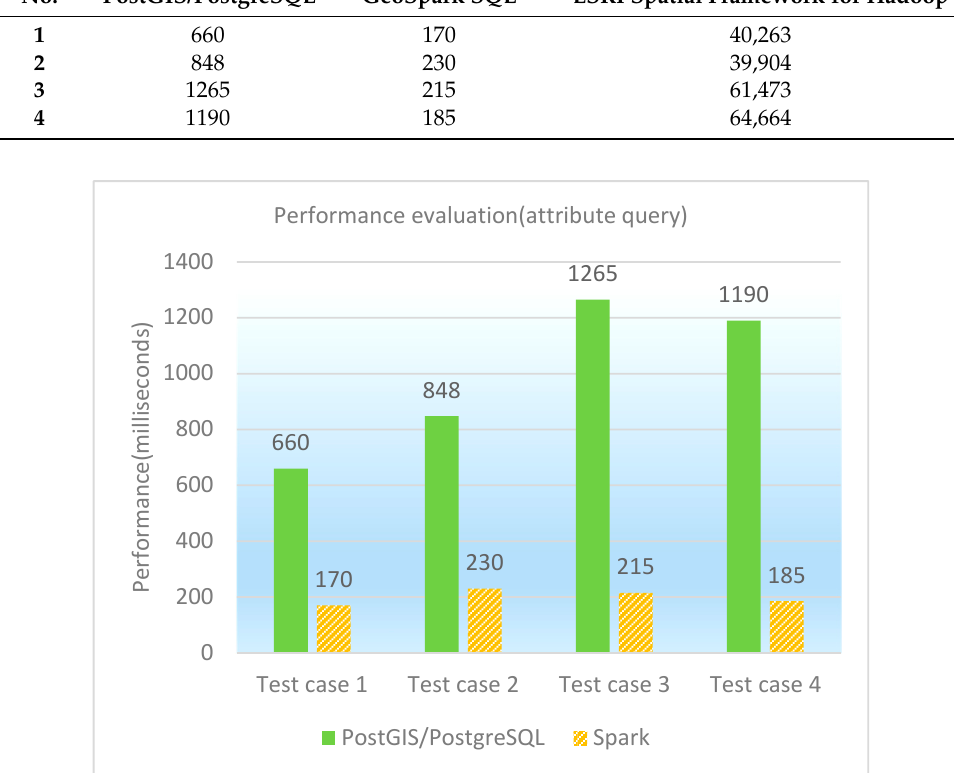
Figure 5. Performance comparison graph of attribute queries (in milliseconds).